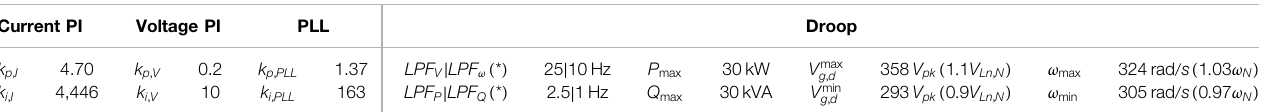
TABLE 2 | converters controllers